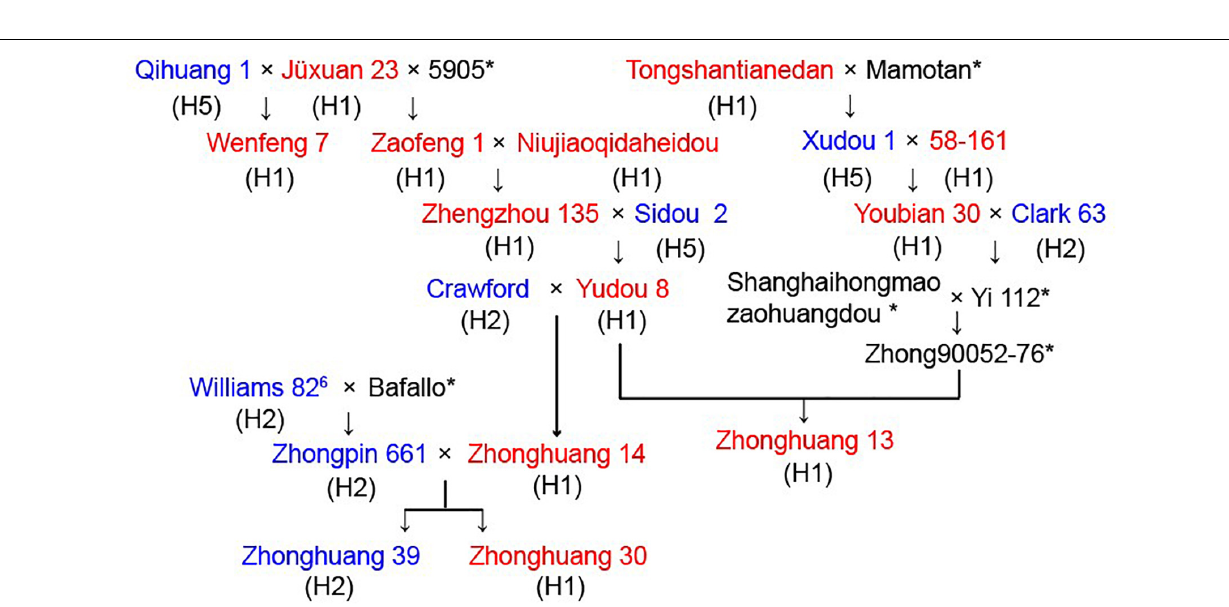
Frontiers in Plant Science |